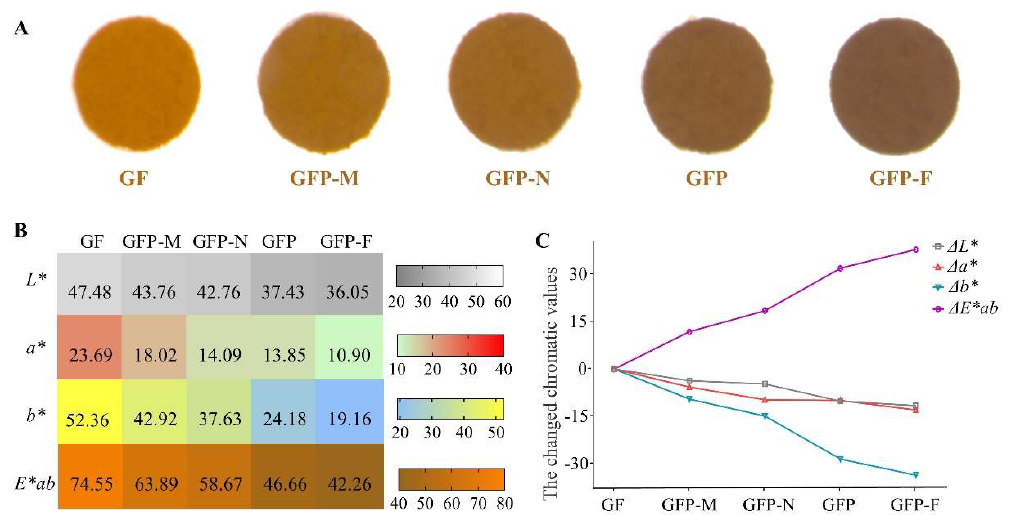
Figure 3. The result of color analysis of GF (pre−processed pieces), GFP−M (middle−processed pieces), GFP−N (near−processed pieces), GFP (the right processed product), and GFP−F (far−pro- cessed pieces). ( A ) Intuitive colors. ( B ) The values in the heatmap represent the corresponding L* , a* , b* , and E*ab values of each decoction piece. The L* value from large to small indicates luminance from light to dark. The a* value from large to small indicates color from red to green. The b* value from large to small indicates color from yellow to blue. The E*ab values from large to small mean color change from GF to GFP-F. ( C ) The values of Δ L* , Δ a* , and Δ b* represent the changed chroma values of L* , a* , and b* compared to the original value of GF, respectively. Δ E*ab represents color difference values.